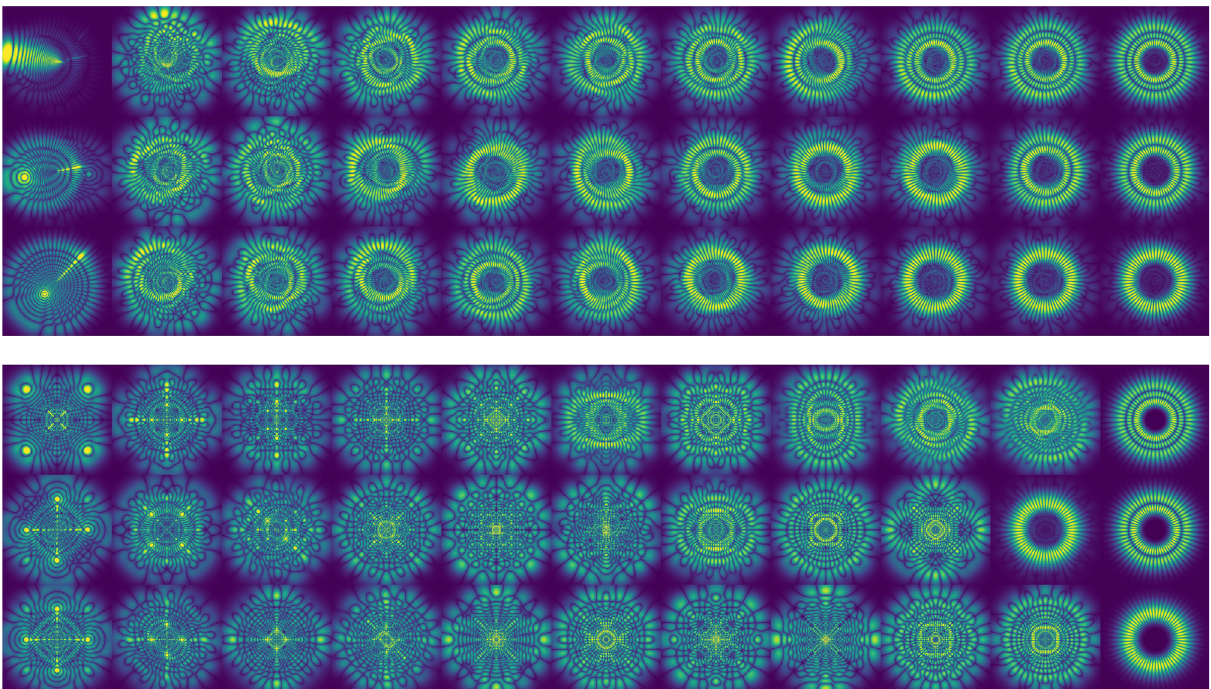
FIG. 4. The electron density j Ψ ð r Þj 1 = 2 of selected eigenstates of a ν ¼ 30 2D composite. Both panels display from bottom to top the first, third, and fifth eigenstates. Top: Probability densities for a dense lattice ( d ¼ 20 ) increasing in fill factor from left to right in steps of 0.1 excluding the first panel where only five scatterers are present. Bottom: Probability densities for a full lattice with d ¼ f 1000 ; 500 ; 300 ; 200 ; 100 ; 90 ; 80 ; 70 ; 60 ; 54 ; 20 g ,